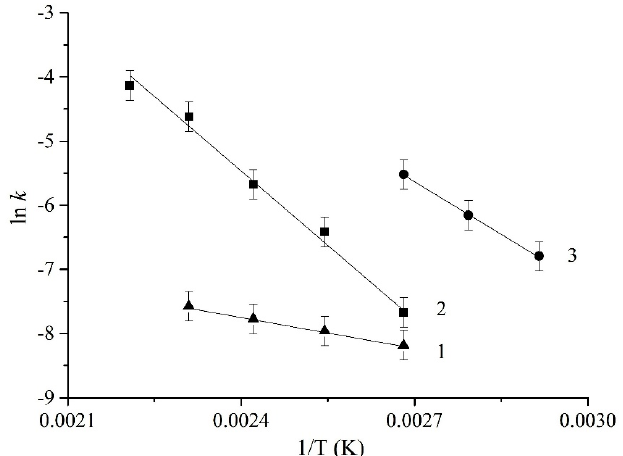
Figure 15. Dependence of the rate constants of the leaching process of altered ilmenite on the temperature in the coordinates of the Arrhenius equation: (1) before the reaction mixture was solidified; (2) after solidification of the reaction mixture; (3) leaching at the NaF presence (the mass ratio of ilmenite to NaF is 1:1).